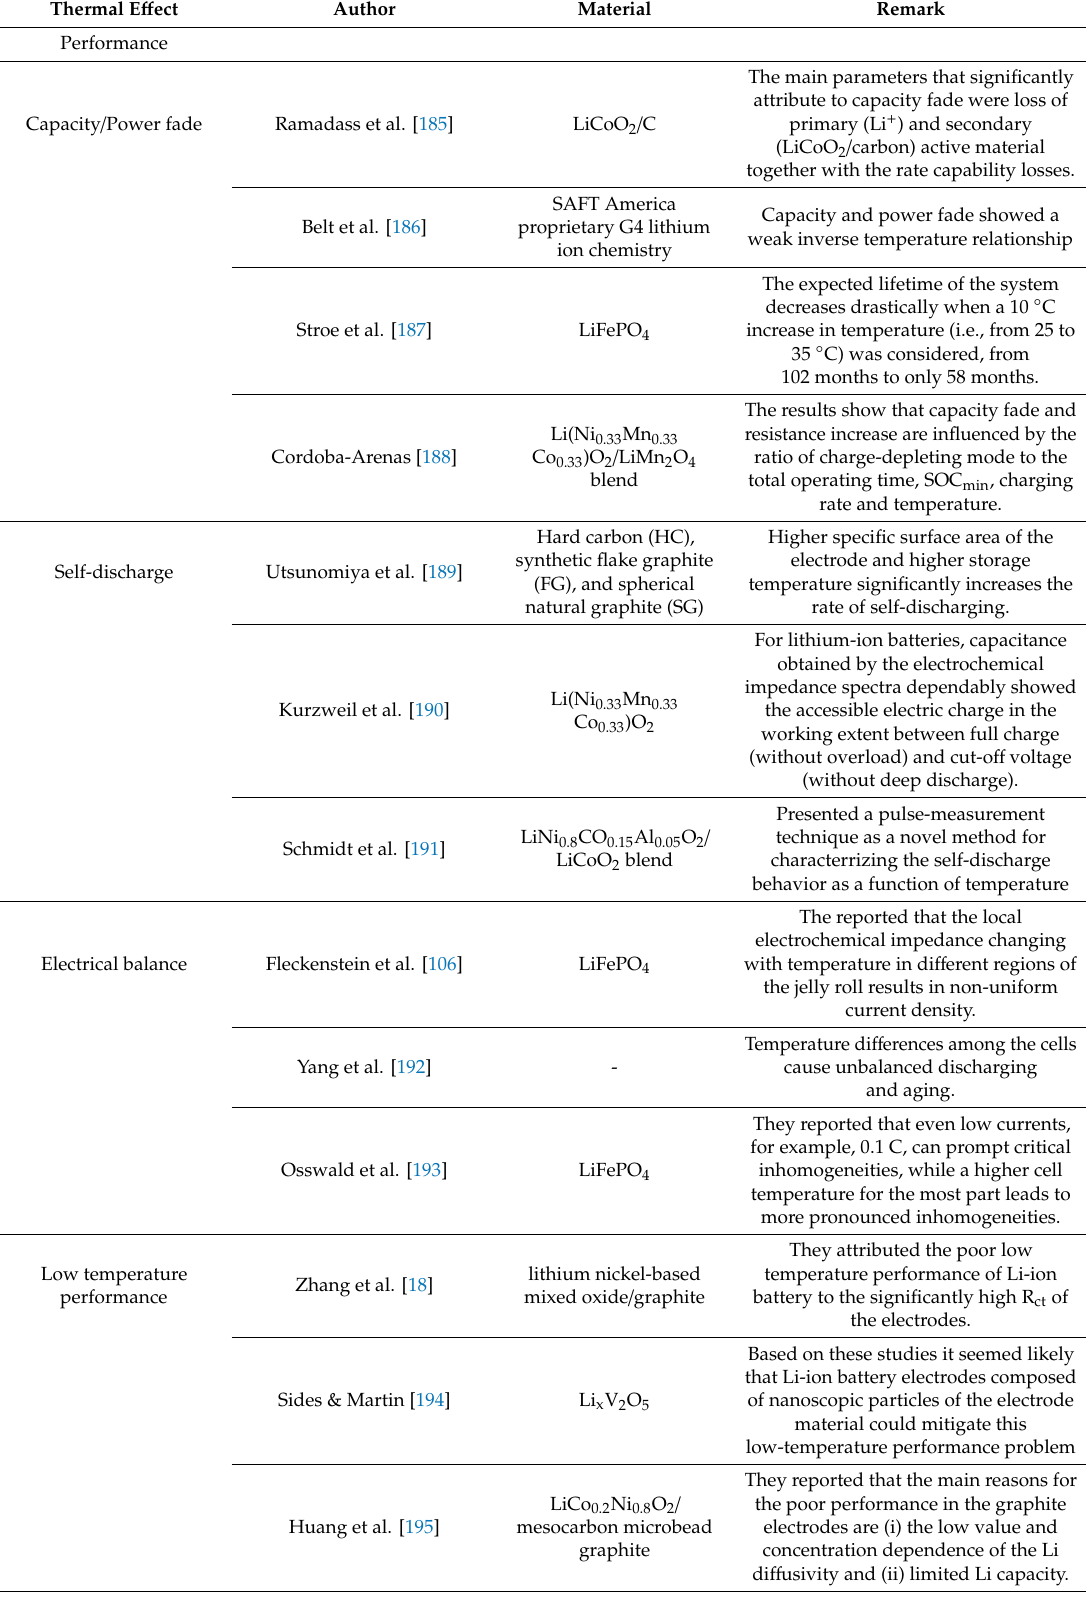
Table 1. Review of thermal e ff ects on lithium-ion batteries (LIB)’s performance and